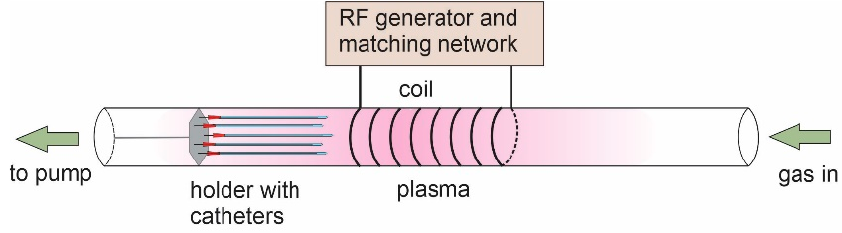
Figure 4. Contact angles of water and diodomethane droplets along the catheter tube: ( a ) PVC cath- eter and ( b ) TPE catheter. Zero on the x-axis corresponds to the end of the catheter tube which is closer to the coil (see Figure 5). Contact angles for untreated samples are added.